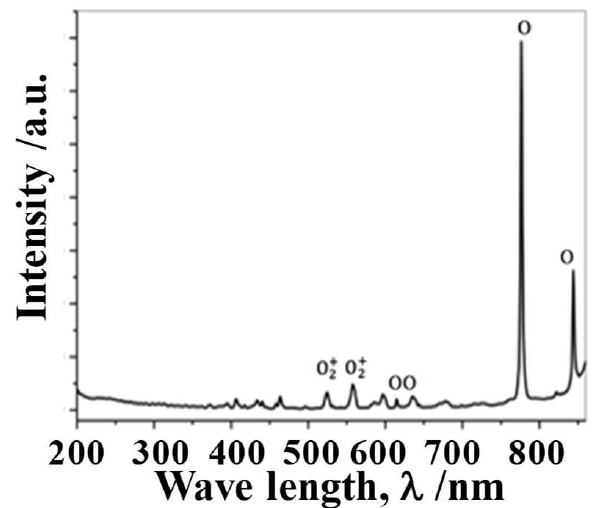
Figure 4. EOS spectrum of activated oxygen atoms and ions during the etching process.